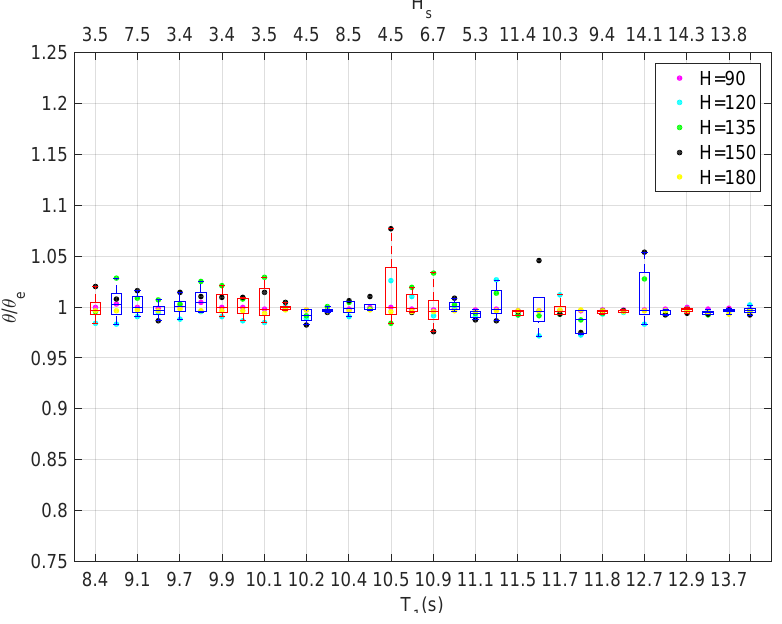
Figure 9. Box-plot showing the ratio between the estimated and measured mean wave direction, obtained by means of the alternative prior